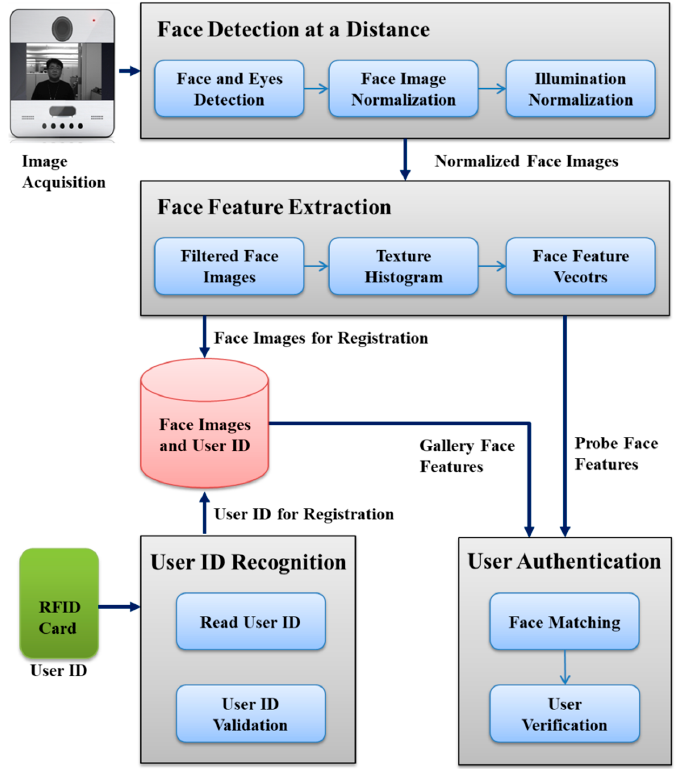
Figure 7. Overall architecture of the proposed user-friendly, stand-alone access control system based on human face recognition at a distance with RFID.